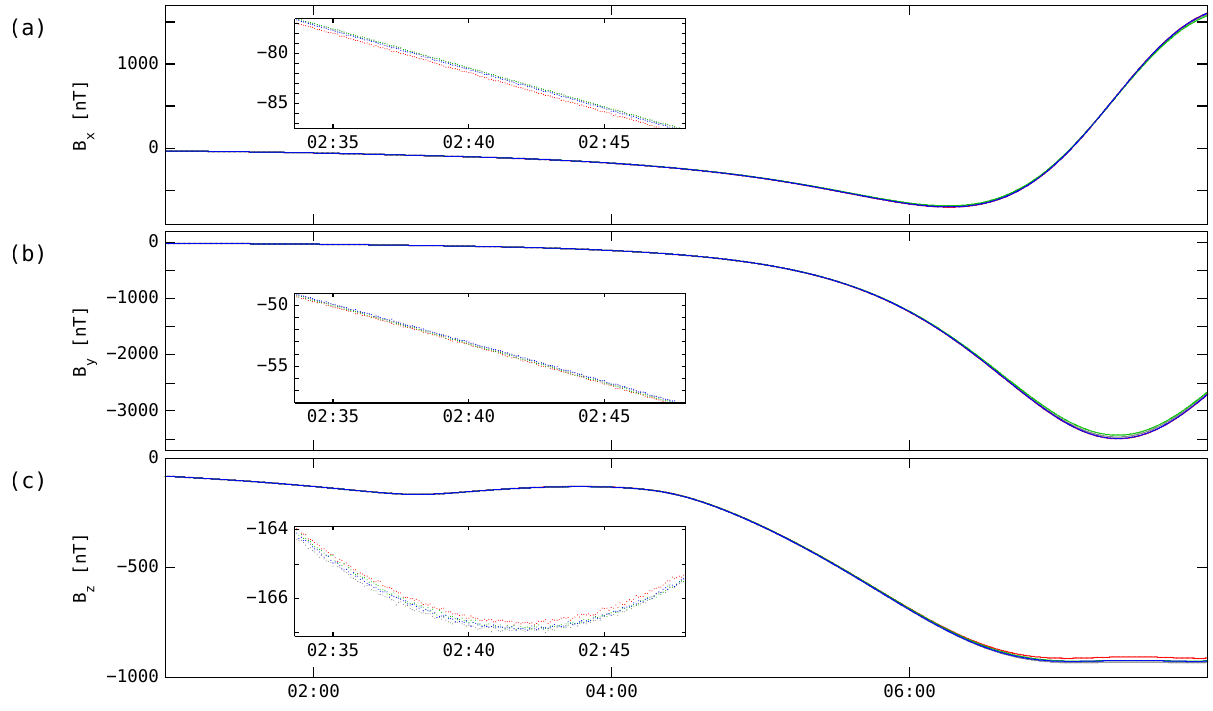
Fig. 12. Magnetic field profiles for a 4-spacecraft configuration at 150km separation flying through the dipole with ring current depicted in Fig. 11. The trajectories are parallel straight lines, scanning along x and y with speeds of 2 and 0.5km · s − 1 , respectively, at a constant z of 1 R E . The figure shows the field as the spacecraft move in towards perigee. The insets zoom in on the magnetic field data around the time when the spacecraft enter the ring current region; the magnetic field differences are of the order of 1nT or less while the fields are supposed to be measured with a 0.1nT precision.